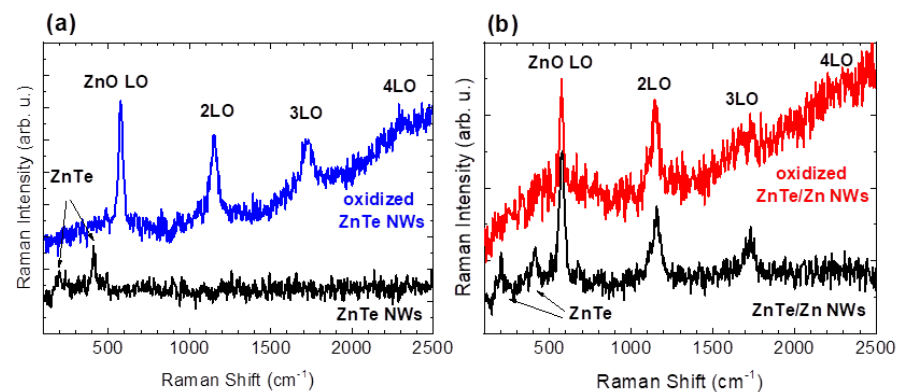
Figure 7. Raman scattering spectra of unprocessed (bottom black curves) and oxidized NWs for ( a ) bare ZnTe NWs (upper blue curve) and ( b ) Zn-covered ZnTe NWs (upper red curve). These spectra are collected at ZnO resonant conditions ( λ = 325 nm).